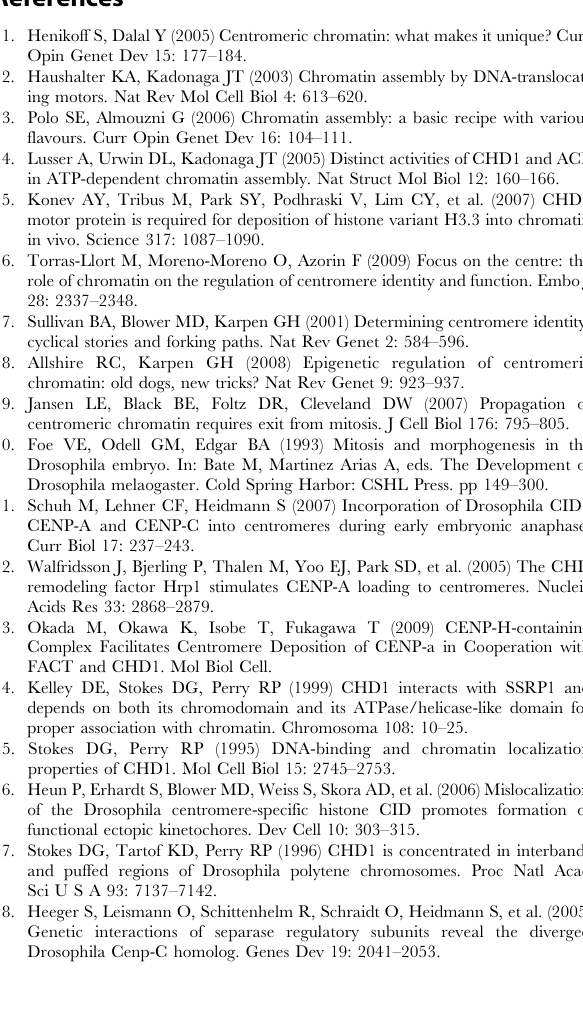
antibodies (green) and DAPI to visualize DNA (red). Stainings were performed in cells at day 4 of RNAi treatment. C) Signal intensities of centromeric foci after staining with anti-CenH3 CID antibodies were quantified as described in Materials and Methods. Error bars denote standard deviations of signals obtained from 148 untreated and 115 RNAi-treated nuclei, respectively, after 4 days of dsRNA